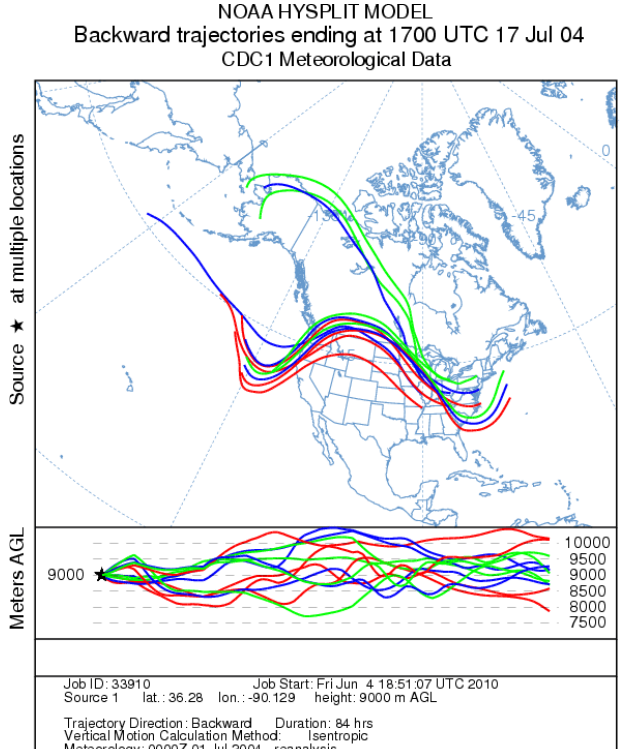
Fig. A1. Map (a) and distribution (b, c) of spatial locations of aircraft observations categorized by age groups (initial, fresh, young, mid-age, and old). Age group definitions are shown in Fig. 4.